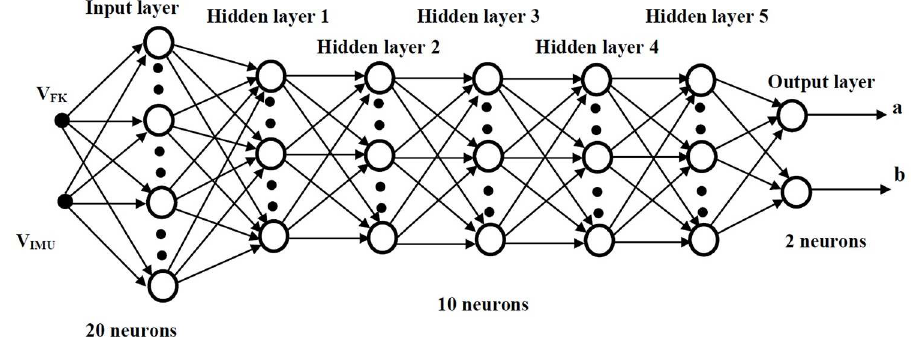
Fig 13. Overall MLF structure including hidden layers.